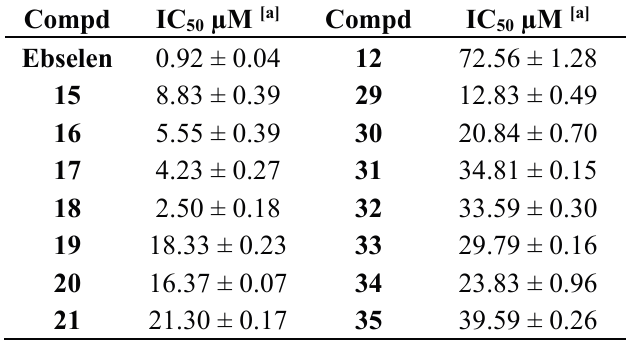
Table2. Inhibition of PN-mediated oxidation reaction of dihydrorhodamine 123 by ebselen , compound 12 , selenides 15 – 21 and spirodiazaselenuranes 29 – 35